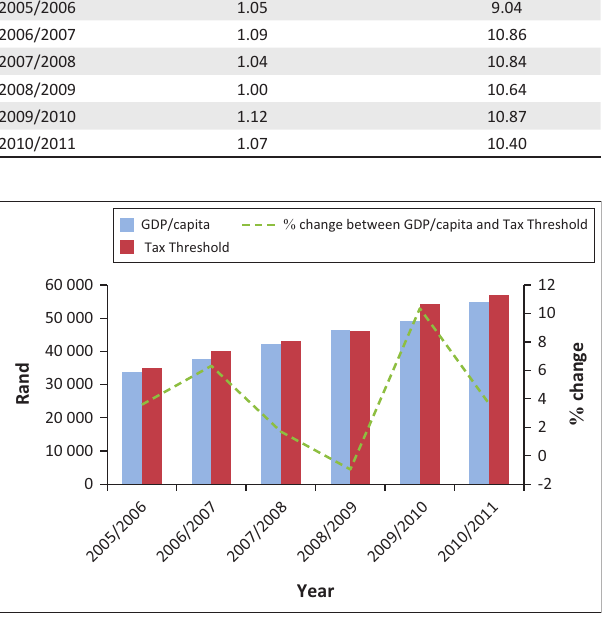
FIGURE 3: GDP/per capita and Tax threshold.